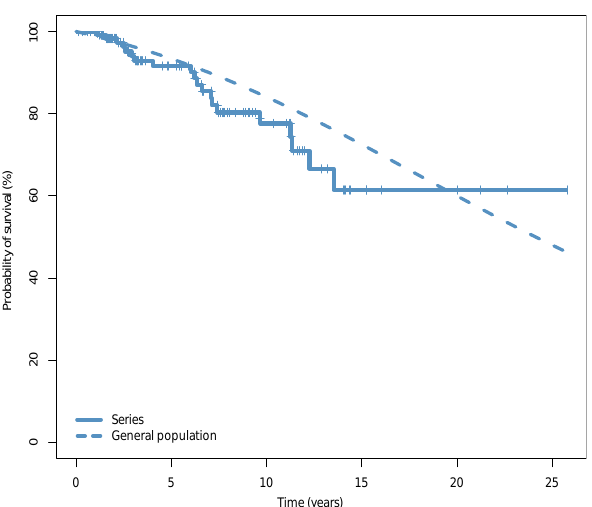
Figure 3. Overall survival of the patients of the series (continuous line) and survival of an age- and sex-matched Spanish general population (dashed line).